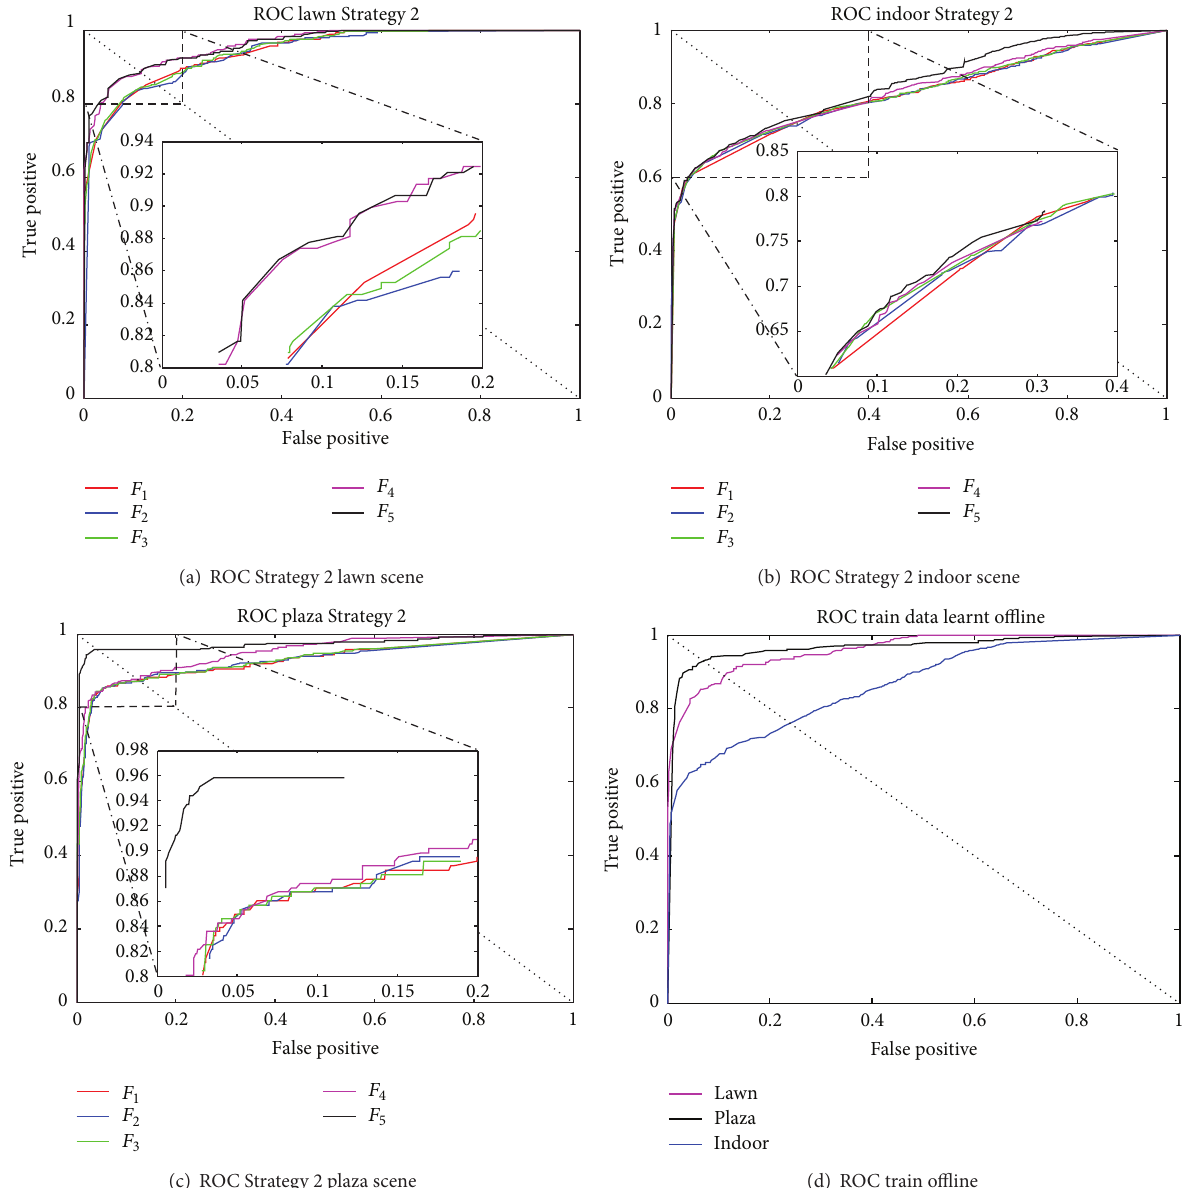
Figure 8: ROC curve of UMN dataset. (a) ROC curve of different features 𝐹 results via Strategy 2 of the lawn scene. The biggest AUC value is 0.9605. (b) Strategy 2 results of the indoor scene. The biggest AUC value is 0.8495. (c) Strategy 2 results of the plaza scene. The biggest AUC value is 0.9746. (d) The ROC curve of best performance of the lawn, indoor, and plaza scene when the training samples are learnt offline. The biggest AUC values of the lawn, indoor, and plaza are 0.9591, 0.8649 and 0.9649. the dictionary and the classifier are not changed.